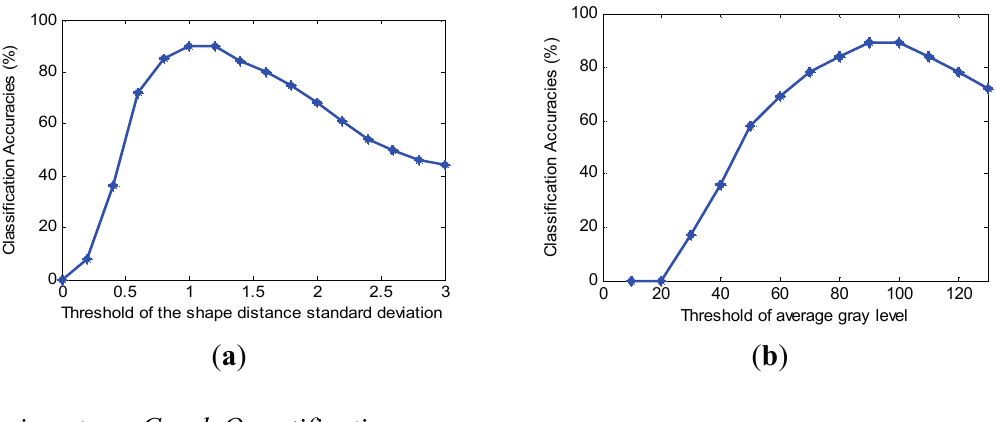
Figure 12. Classification accuracies with different thresholds: ( a ) accuracies with different ; ( b ) accuracies with different (cid:1846) (cid:1846) (cid:3097)